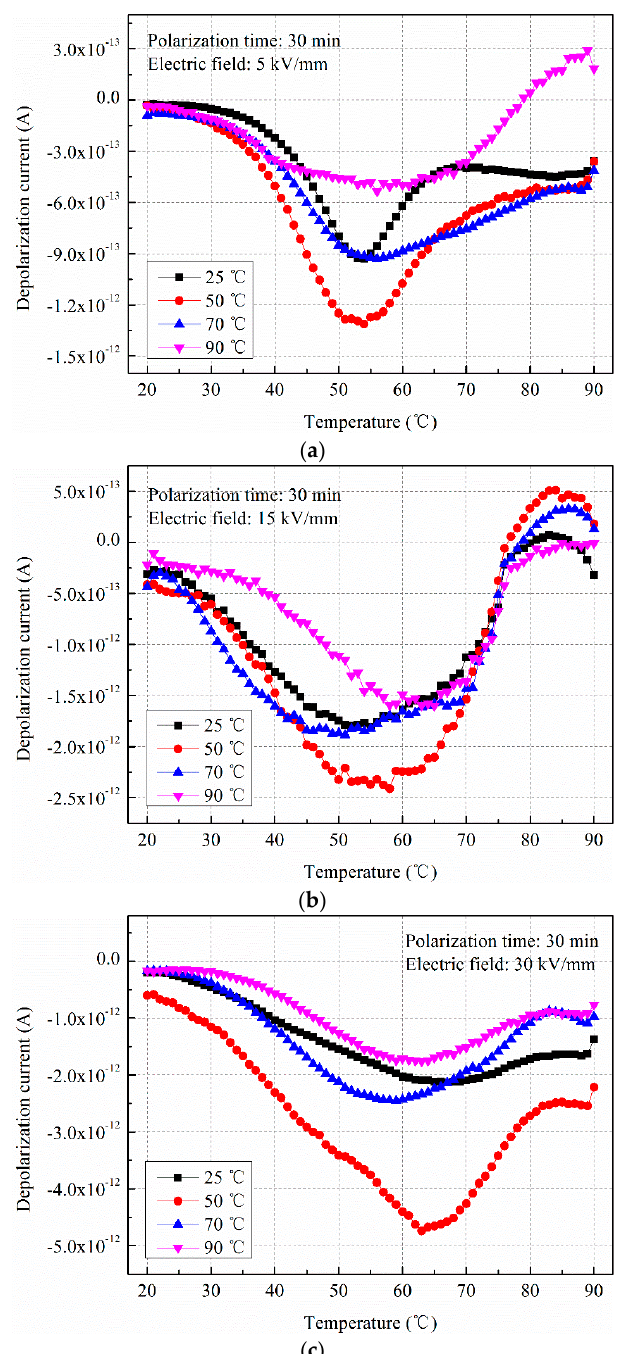
Figure 2. The depolarization current curves in low density polyethylene (LDPE) polarized by different temperatures and electric fields. ( a ) 5 kV/mm; ( b ) 15 kV/mm; ( c ) 30 kV/mm.